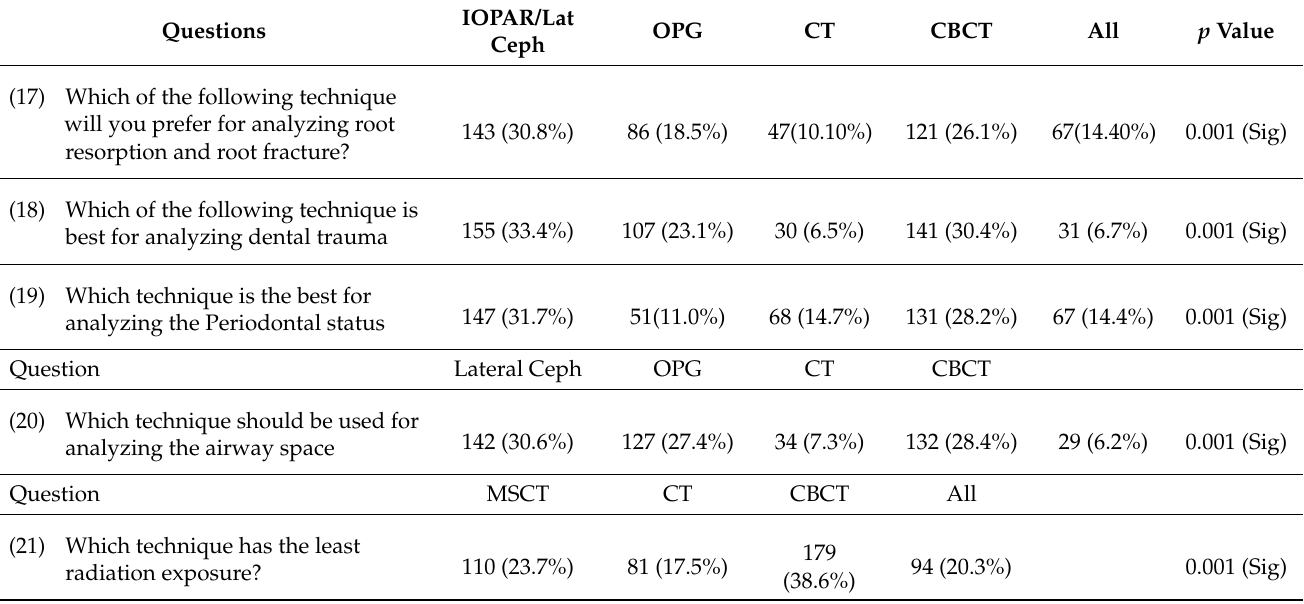
Table 2. Choice of diagnostic